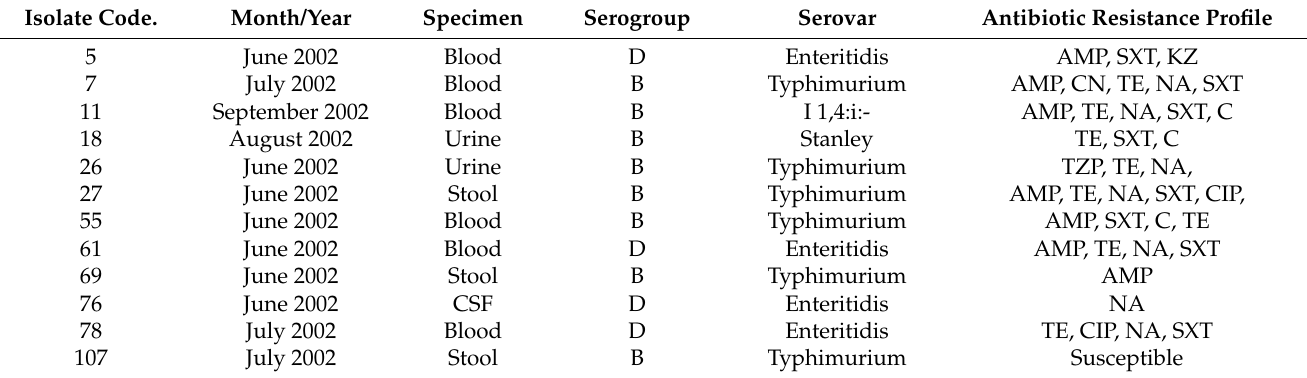
Table 1. Twelve clinical Salmonella isolates used for antibacterial and antibiofilm assays in this study. Isolate